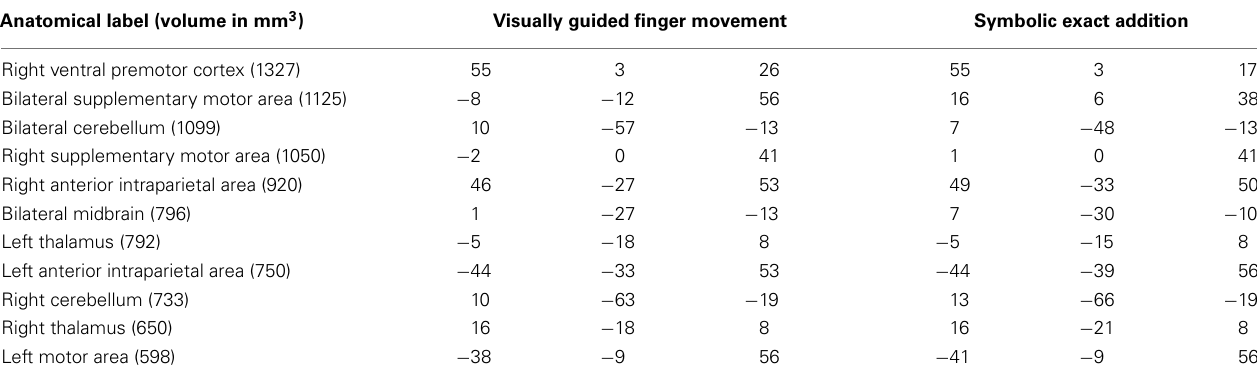
Table 4 |Anatomical labels and volumes in cubic millimeter of clusters significantly activated only in the visually guided finger movement task and the symbolic exact addition tasks, but in no other task (depicted in yellow in Figure 3) with respectiveTalairach coordinates ( x y z ) of peak values for all included tasks.